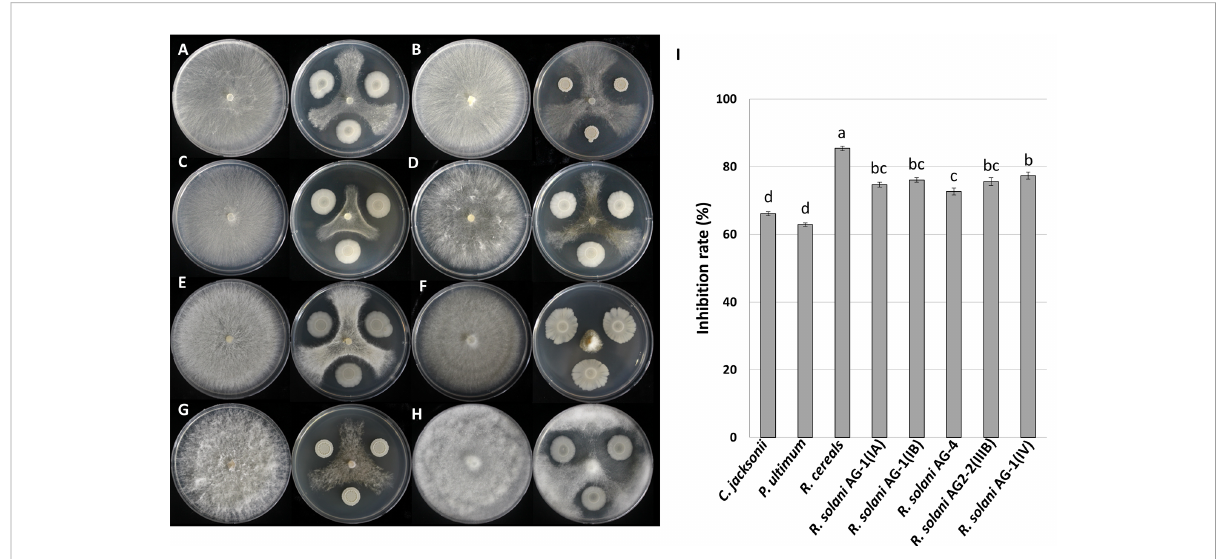
FIGURE 1 Antifungal activity of Bacillus velezensis GH1-13 against eight plant pathogens. (A) Rhizoctonia solani AG-1 (IA), (B) R. solani AG-1 (IB), (C) R. solani AG2-2 (IIIB), (D) R. solani AG2-2 (IV), (E) R. solani AG-4, (F) Rhizoctonia cerealis , (G) Clarireedia jacksonii , and (H) Pythium ultimum , and (I) inhibition rates of the pathogens. The bars followed by the same letter are not signi fi cantly different at P< 0.05 in Tukey ’ s HSD